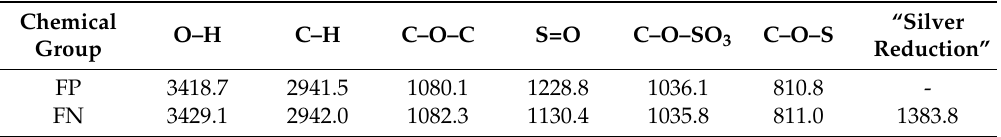
Figure 2. Fourier transform infrared spectroscopy (FTIR) spectra of fucan polysaccharide (FP) and fucan-coated silver nanoparticles (FN).